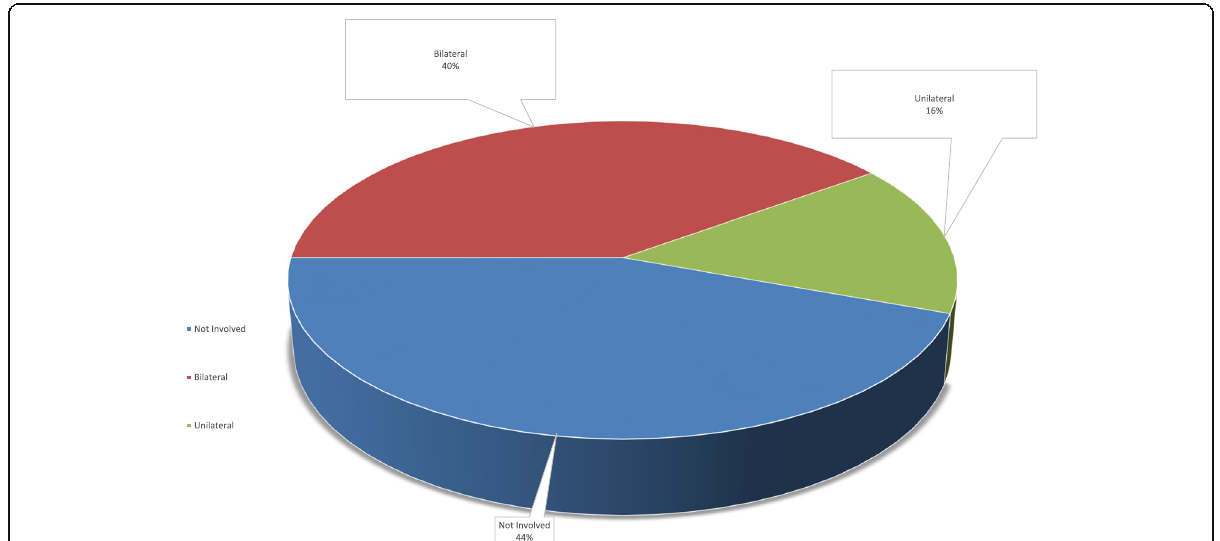
Fig. 4 Iliac crest involvement in positive PET/CT